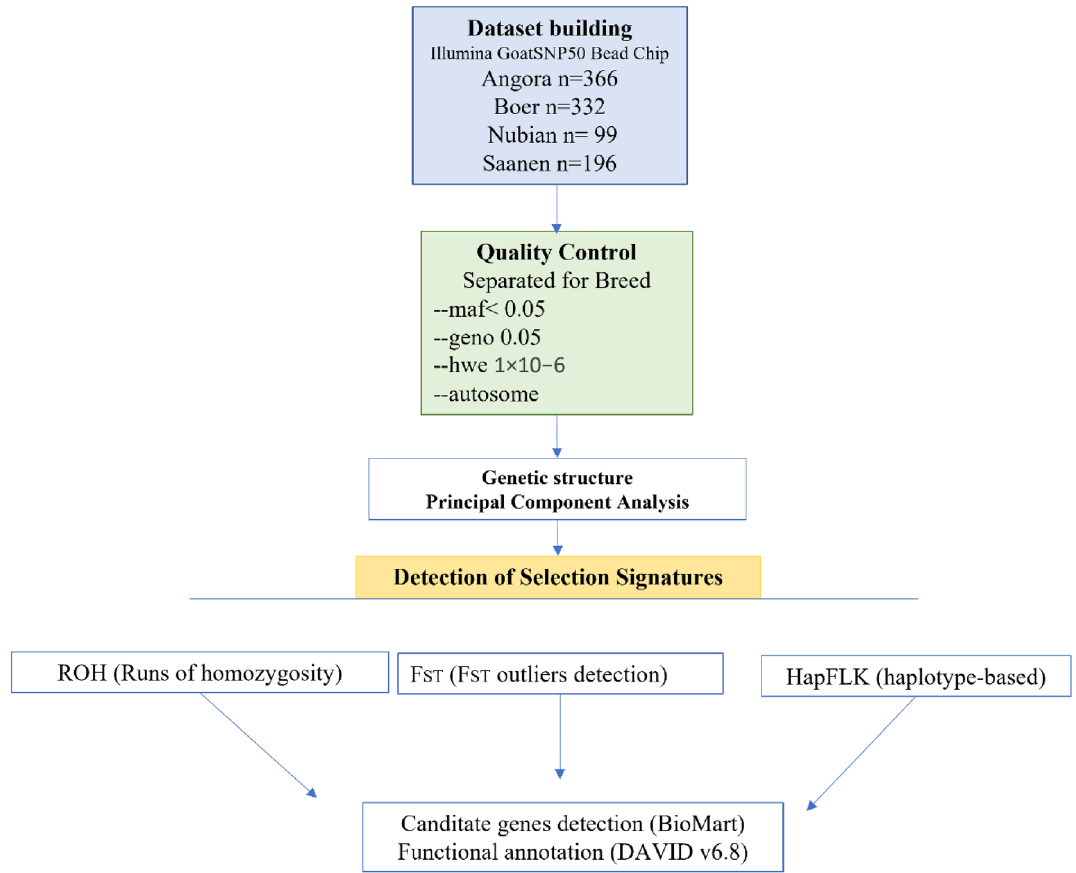
Figure 8. Graphical representation of workflow followed for detecting genetic signatures for